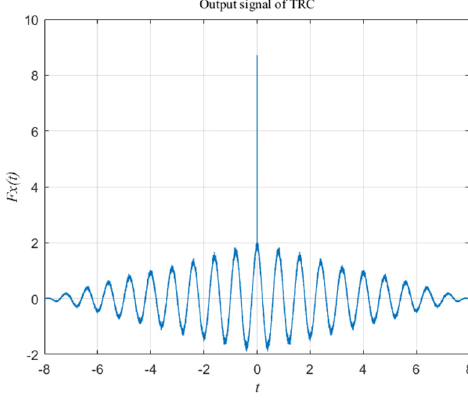
Figure 2. Result of the time reversal convolution (TRC) operation.